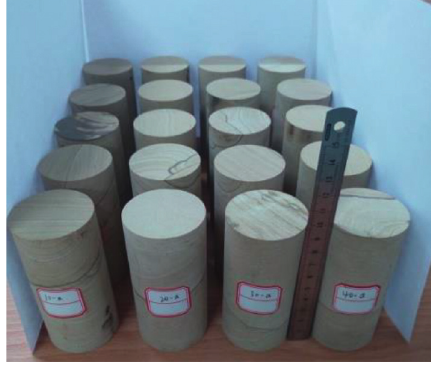
Figure 1: Yellow sandstone samples.